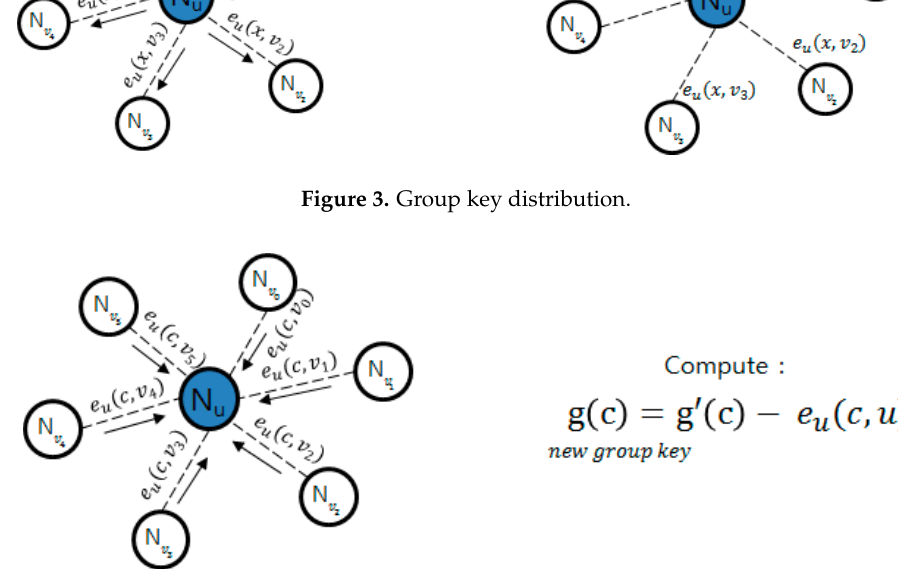
Figure 4. Group key update method.